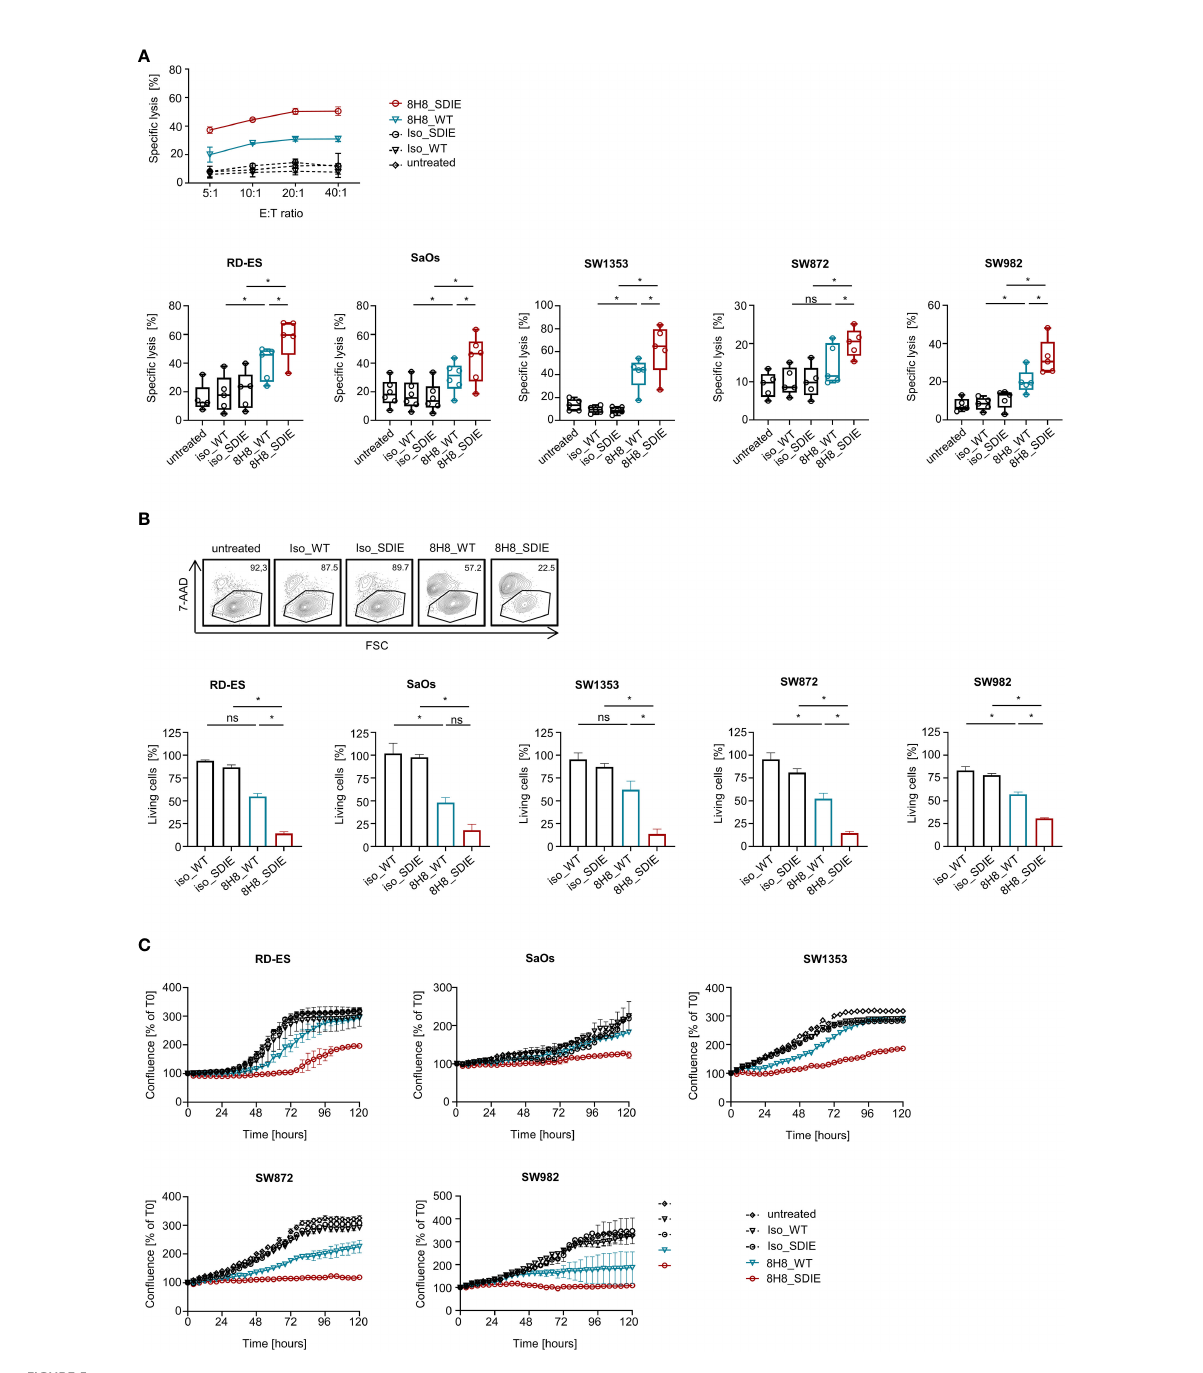
FIGURE 5 Induction of target cell lysis by Fc optimized B7-H3 antibody. PBMC of healthy donors were incubated with different sarcoma cell lines (n = 5) and treated without or with indicated B7-H3 antibodies or corresponding isotype controls (1 m g/mL). (A) Lysis of sarcoma cell lines RD-ES, SaOs, SW1353, SW872 and SW982 (n=5) was analyzed by 2 h Europium cytotoxicity assays. In the top panel, exemplary data obtained with SW982 and one PBMC donor with different E:T ratios and in the bottom panel, pooled data for each cell line obtained with PBMC of healthy donors (n=5) at an E:T ratio of 20:1 are shown. (B) Lysis of sarcoma cell lines RD-ES, SaOs, SW1353, SW872 and SW982 (n=5) was determined after 72 h by fl ow cytometry-based lysis assays at an E:T ratio of 10:1. In the top panel exemplary dot plots with SW872 and one PBMC donor are shown, the bottom panel depicts combined results for each cell line with PBMC (n=5) of healthy donors. (C) Cell death of sarcoma cells was determined using a live cell imaging system. Sarcoma cell lines RD-ES, SaOs, SW1353, SW872 and SW982 were incubated with PBMC of two healthy donors at an E:T ratio of 10:1 for 120h. T=0 h corresponds to a con fl uence of 100%. Results are shown as mean ± SD. ns, not signi fi cant; *statistically signi fi cant differences (p-value <